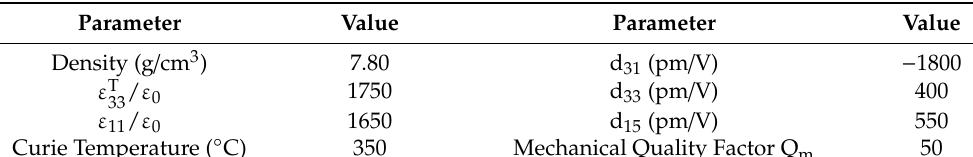
Figure 12. PZT sensors attached to the curved supporting structure.